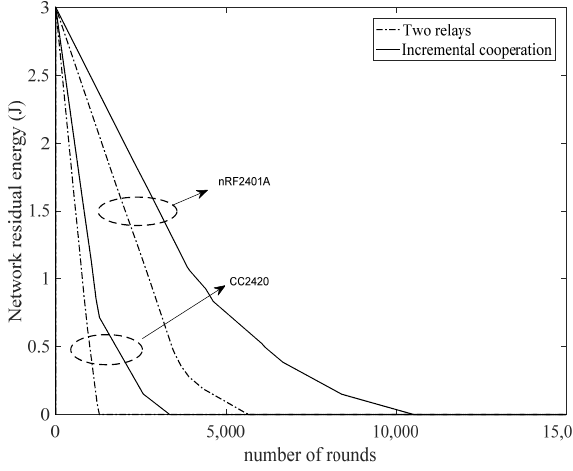
Figure 13. The residual energy versus the network lifetime.